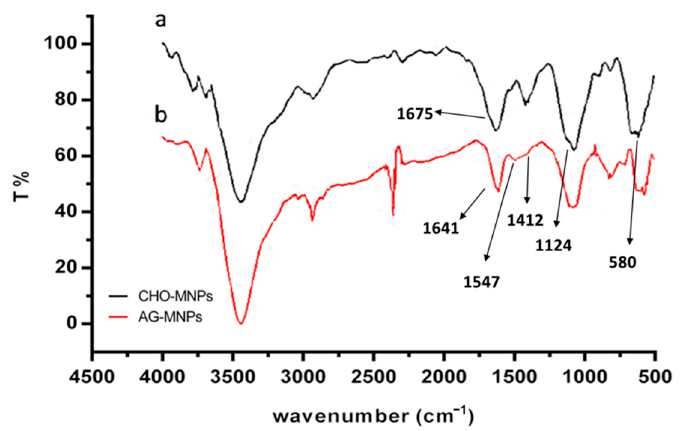
Figure 1. FT-IR spectrum of ( a ) CHO-MNPs, ( b ) AG-MNPs.